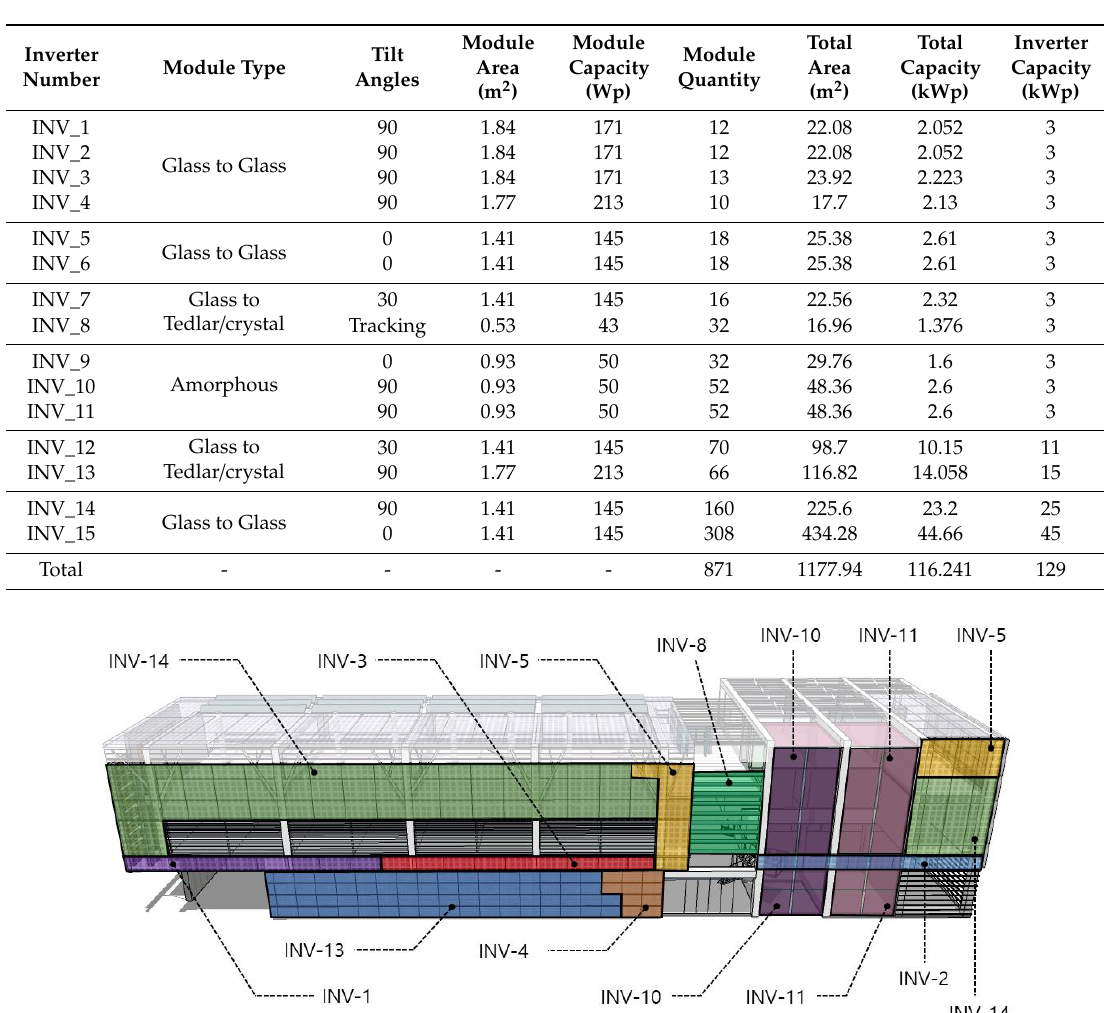
Table 3. PV module installation overview.